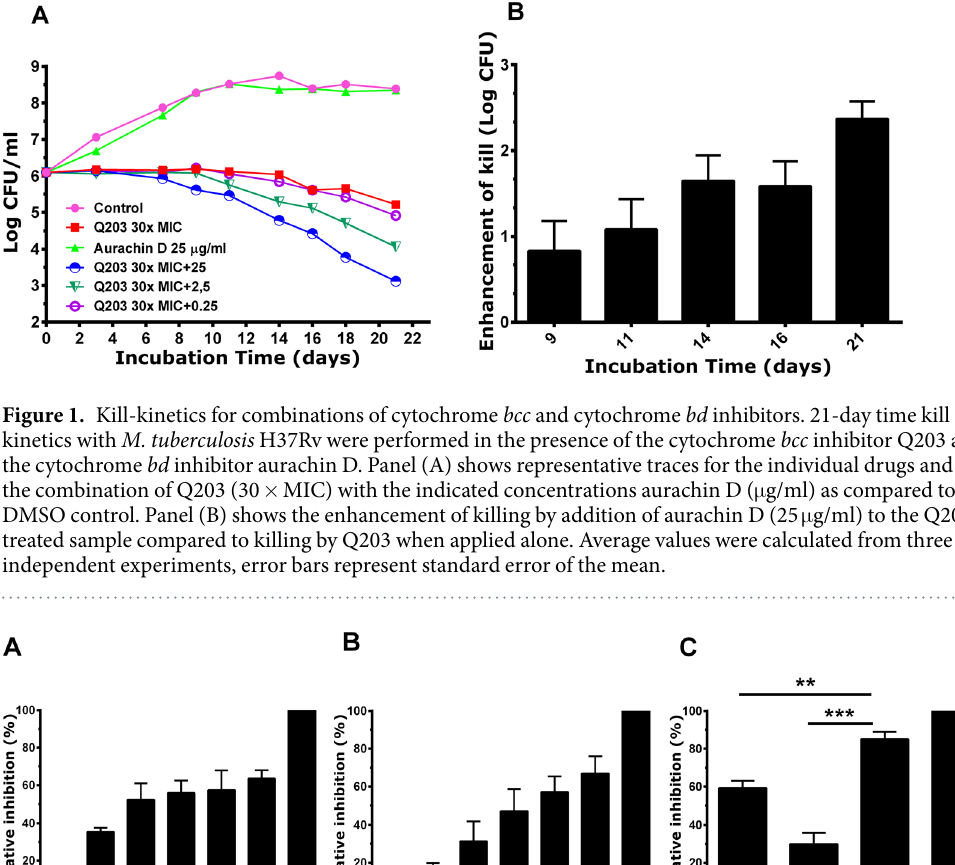
3 SCIentIFIC REPORTS | (2018) 8:2625 | DOI:10.1038/s41598-018-20989-8